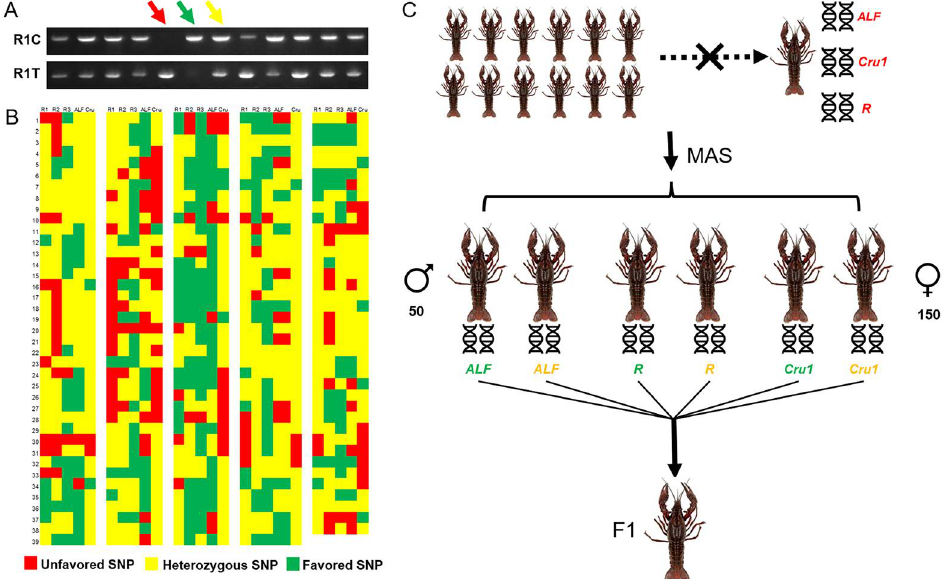
Figure 1. Selection of parents and breeding of offspring for stress and disease resistance in crayfish. ( A ) Electrophoresis gel images of partial PCR products for examining single-nucleotide polymorphism (SNP) (R1) genotype; red, green, and yellow arrows indicate homozygous unfavoured genotype TT, favoured genotype CC, and heterozygous genotype C/T, respectively. ( B ) Genotype diagram of F3 population selected for rapid growth divided into five columns; horizontal and vertical rows represent different individuals and R1, R2, R3, ALF, and Cru SNP sites in each column, respectively. ( C ) Flowchart of crayfish breeding of “Huachizhen1” for stress and disease resistance generated using molecular-assisted selection. Except for individuals with homozygous unfavoured genotypes, individuals with favoured genotypes and a small number of heterozygous genotypes in the F3 population were selected as parents to breed the offspring F1 population.